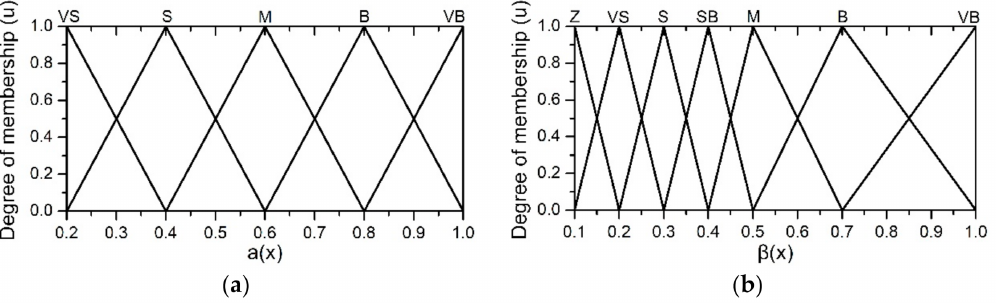
Figure 12. The contraction–expansion factors’ membership functions: ( a ) Input variables a(e) and a(ec) ; ( b ) Output variables β (kp) , β (ki) and β (kd)